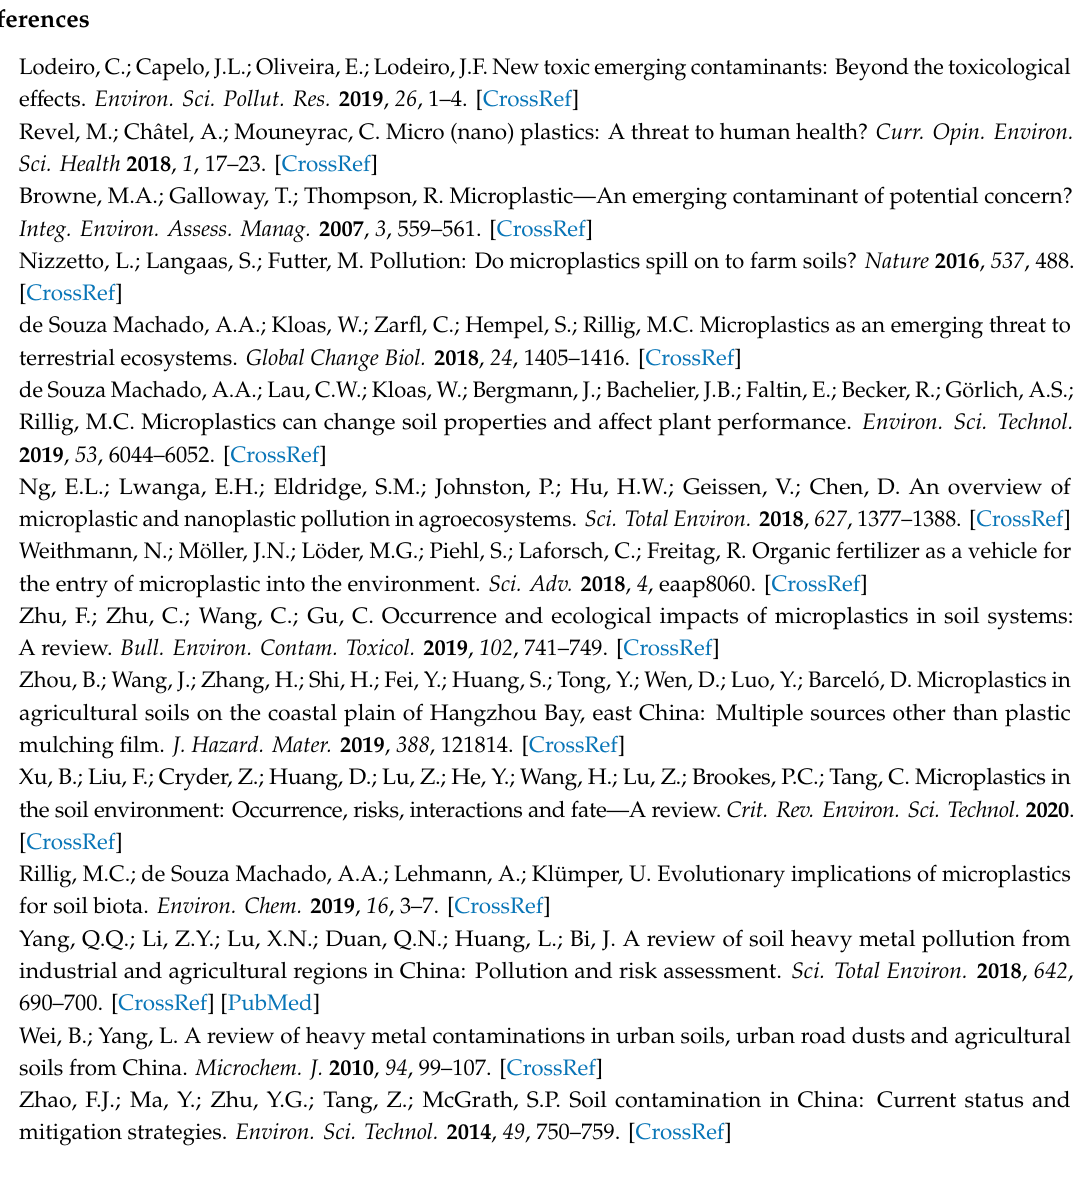
Table S1. BAI of Cd in maize plants exposed to MPs and Cd. Di ff erent letters following the mean values ± SD ( n = 4) in the same column indicate significant di ff erences using a one-way ANOVA followed by Duncan’s multiple range test ( p <